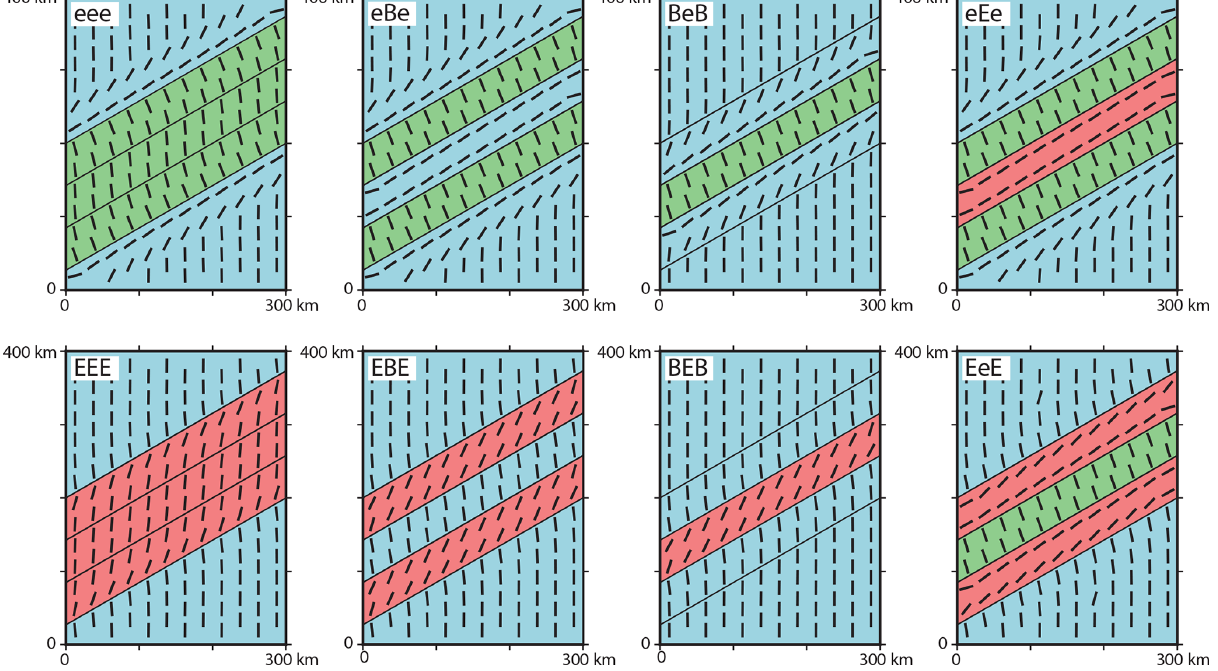
Figure 8. Influence of Young’s modulus variation on the stress orientation. Black bars represent the orientation of S Hmax at a depth of 1000m. Colours indicate the used Young’s modulus; the blue area uses the reference material properties (B: E = 50GPa), the green material uses a low Young’s modulus (e: E = 10GPa) and the red material has a large Young’s modulus (E: E =